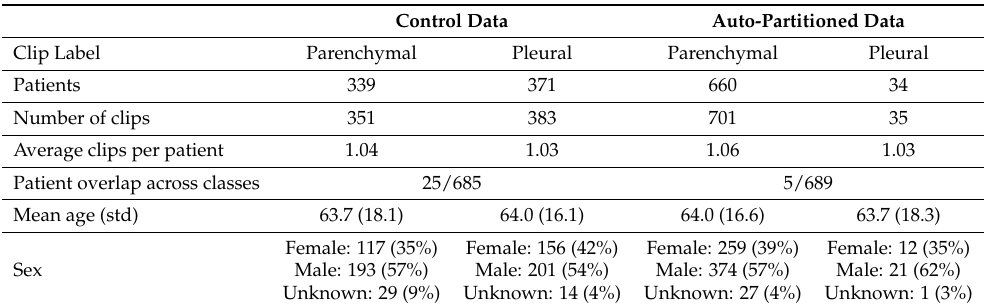
Table 2. Data characteristics of the control and auto-partitioned datasets used for the parenchymal- specific annotation task.